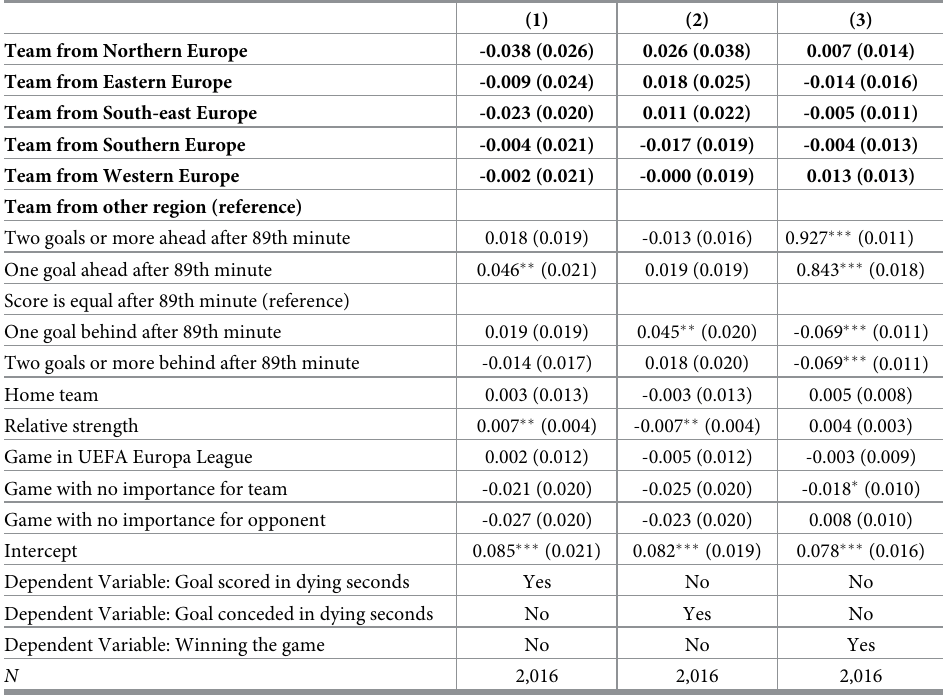
Table 4. Results: Team region indicators as main explanatory